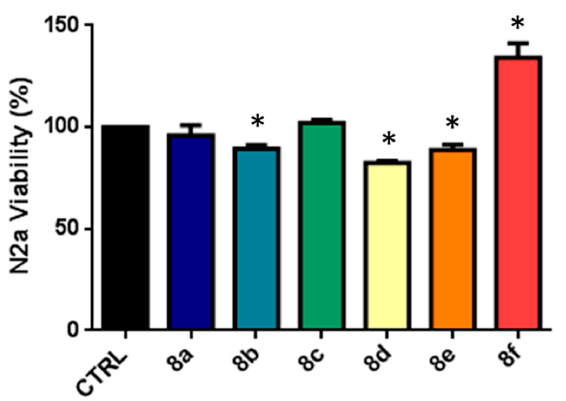
Figure 6. N2a cell line viability in the presence of 10 µ M of compounds 8a–f . Cells were treated with the compounds for 48 h, and the cell viability was measured through the MTT method. This set of compounds does not promote an inhibitory effect on N2a cell viability at 10 μ M. * p > 0.005; n = 3.